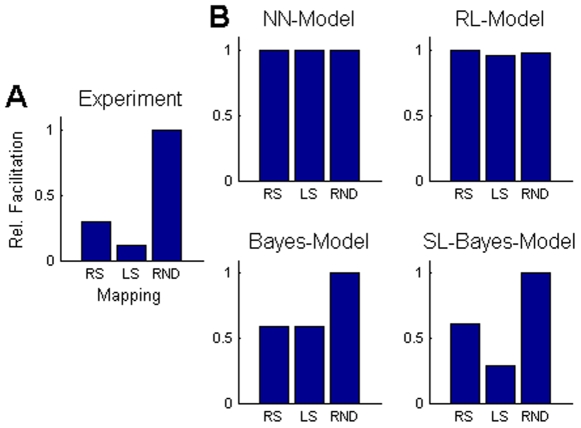
Modelling of the facilitation effect.(A) The experimental data shows a strong facilitation of learning a structured mapping (right-shift or left-shift) compared to a random mapping (RND). In addition, there is also a strong facilitation from learning the first instance of a shift mapping to learning the second instance. (B) The feed-forward neural network (NN) and the reinforcement learning (RL) model show no facilitation effects. The non-hierarchical Bayesian model shows a facilitation effect for the structured mappings if the prior probabilities of these mappings are elevated. The structure learning (SL) Bayes model shows both facilitation effects, because by learning the first mapping the posterior over structures assigns more probability to all other mappings with the same structure. All plots show median values, for the model these were computed over 100 simulation runs.